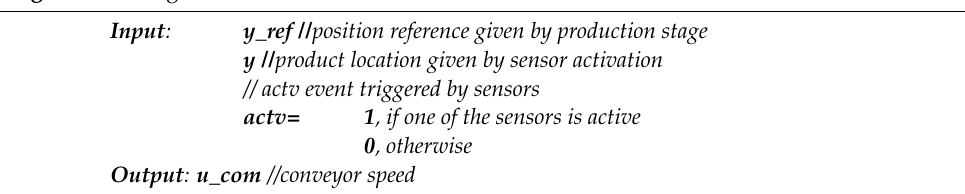
Algorithm 1: Algorithm for Event-Based PID